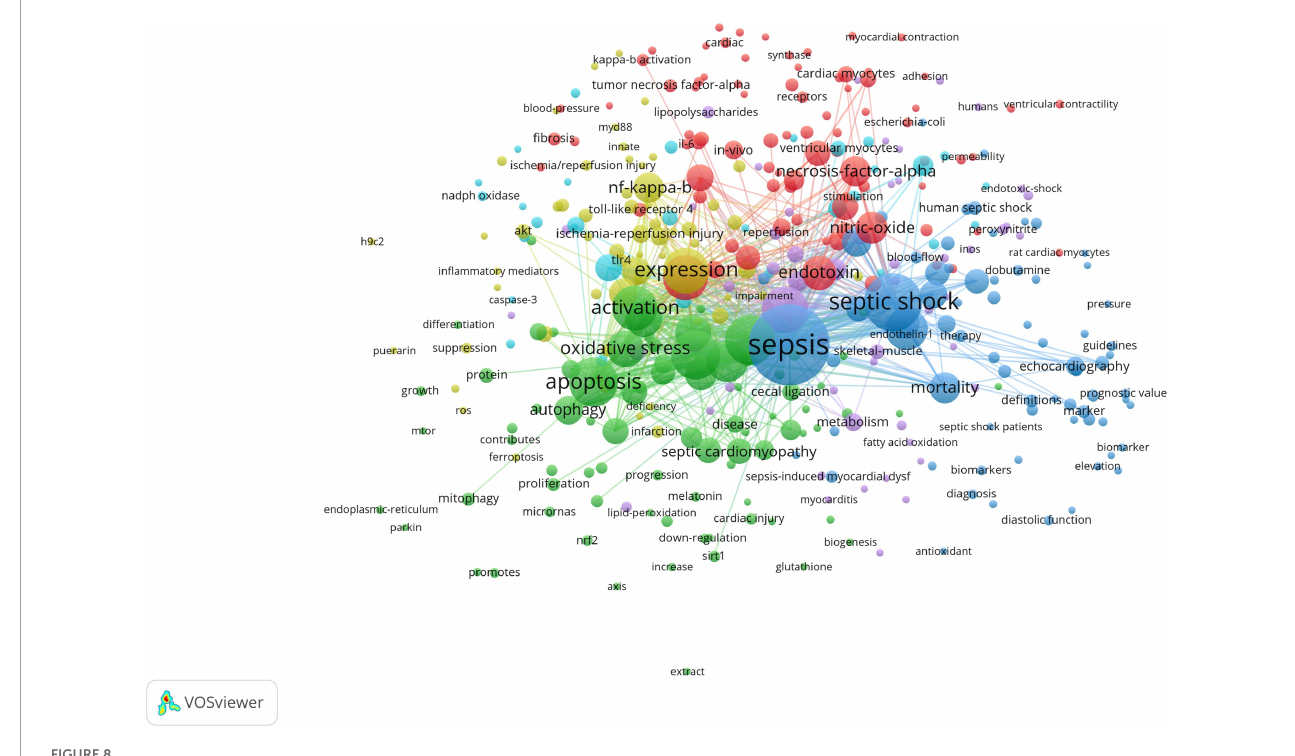
FIGURE8 VOSviewer visualization map of keywords clustering analysis related to SIMD.